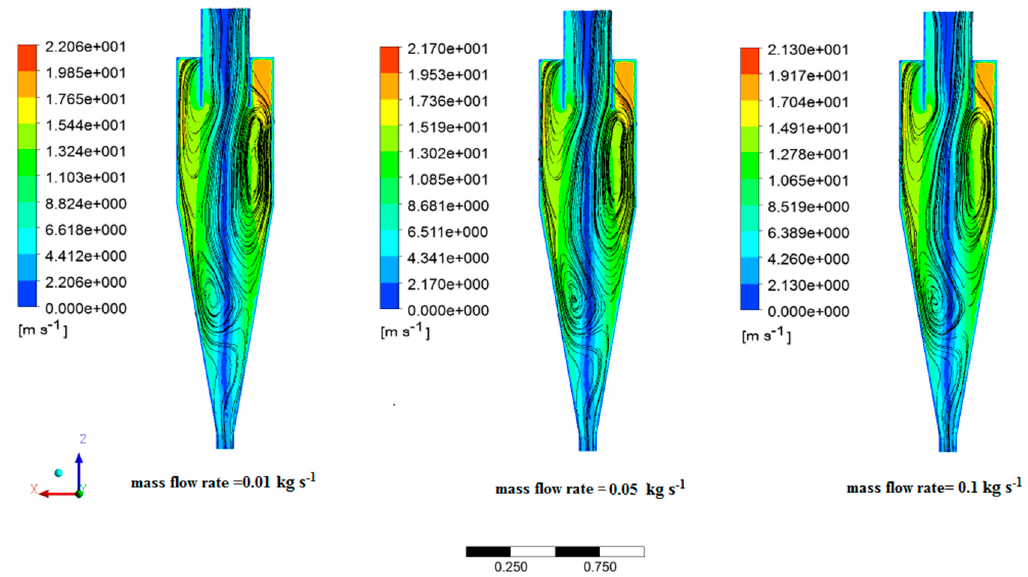
Figure 12. Streamline contours in various mass flow rates.